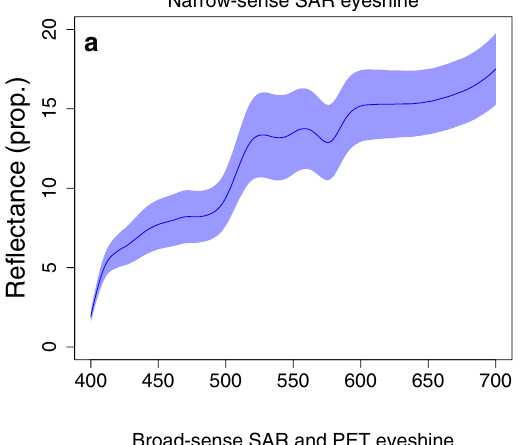
calculated the chromatic contrasts between the pupil and the iris using the receptor-noise model 32 . We informed the model using species-specific visual system parameters including the visual sensitivity of the photoreceptors (SWS: 468 nm, MWS: 517 nm, LWS: 530 nm), the relative photoreceptor densities in the fovea of 1:4:4 (SWS: MWS: LWS), the ocular media transmittance, and setting the Weber fraction at 0.05 31–33 . The achromatic con- trasts were calculated as the absolute Michelson contrast between the luminance photon catches (sum input of the two members of the double-cone) perceived by the prey species. Using the light field measurements at 7 and 15 m depth, we reconstructed three scenarios in which scorpionfish and triplefin were likely to interact: (1) the scor- pionfish and triplefin in the open against bright backgrounds where both PET and SAR eyeshine are present, (2) the scorpionfish in the open and the triplefin in the shade or against a dark background where only PET eyeshine is present (SAR eyeshine is weak or absent because of reduced side-welling illumination), and (3) the scorpion- fish in the shade and the triplefin against a bright background in the open where only SAR eyeshine is induced (see Table S1 for details). The calculations generate values of chromatic contrast in just-noticeable-differences (JNDs), where values greater than one indicate discernible differences 32 , and values of achromatic contrasts as absolute Michelson contrasts (ranging from 0 to 1). To enhance camouflage, the contrast between the pupil and the iris should not only be reduced, but should also be comparable to the contrast of the overall patterning of the fish’s body. To assess the contrast between different skin patches on the body, we used the reflectance of four skin patches around the iris (calculated as the photon radiance of the skin normalized by the respective PTFE white standard facing the spectroradiometer) measured in the field on the three scorpionfish. We calculated the abso- lute Michelson achromatic contrasts as perceived by the prey species (chromatic contrasts between the two pupils and the iris were not showing substantial differences) for all pairwise comparisons of the skin patches under the three scenarios at both depths. We then compared the achromatic contrasts between the irides and the natural and model pupils with the distribution of the skin patches achromatic contrasts. Visual models were implemented using the R package ‘pavo’ 1.0 34 .